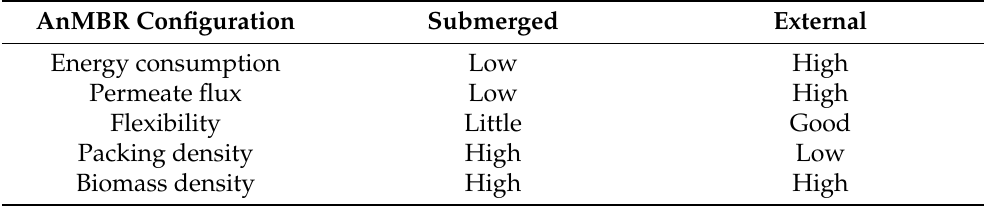
Table 2. The advantages and disadvantages of submerged and external AnMBRs. Based on